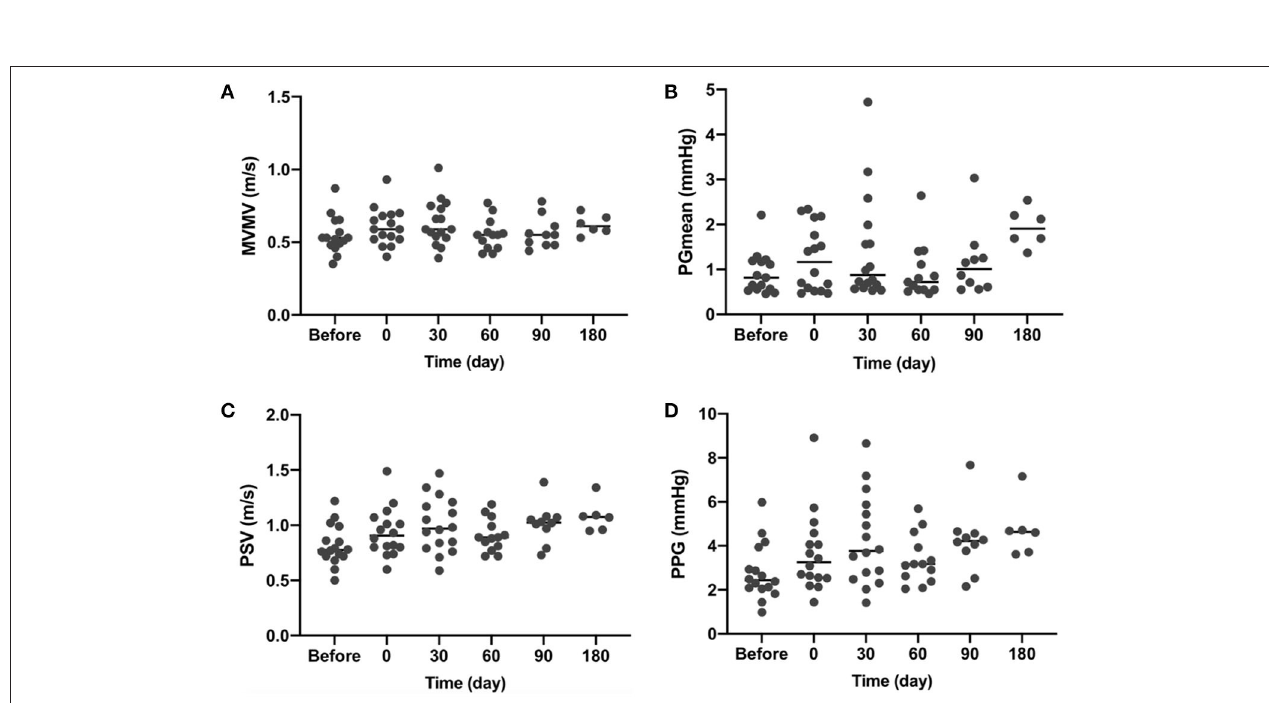
FIGURE 3 | Transthoracic echocardiography (TTE) results at indicated time points. (A) MVMV, mean velocity of the mitral valve; (B) PGmean, mean pressure gradient; (C) PSV, peak systolic velocity; and (D) PPG, a peak pressure gradient.